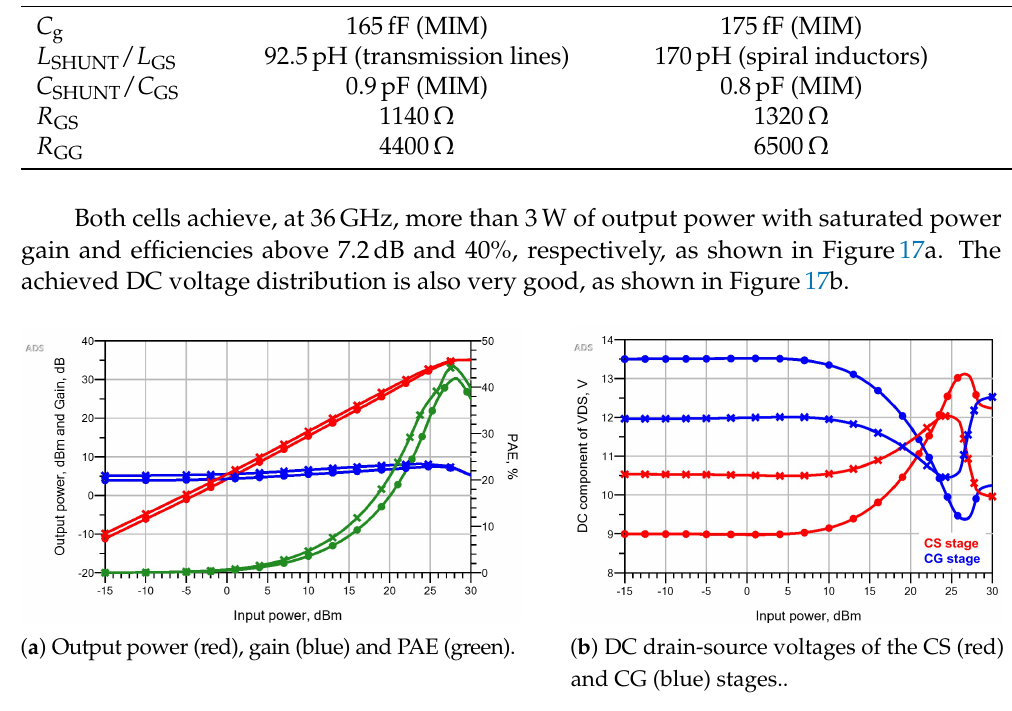
Figure 17. Optimized circuit-level performance of the L SHUNT -based (circles) and L GS -based (crosses) cells at 36GHz.